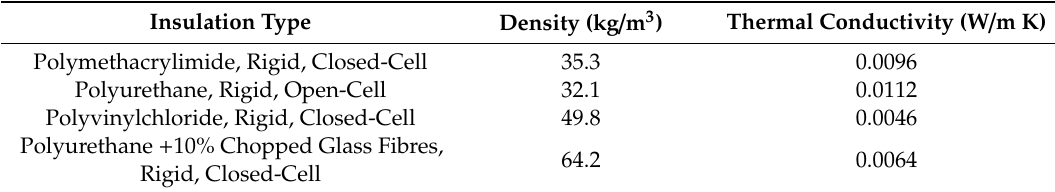
Table 3. Polymer foam insulation materials and properties